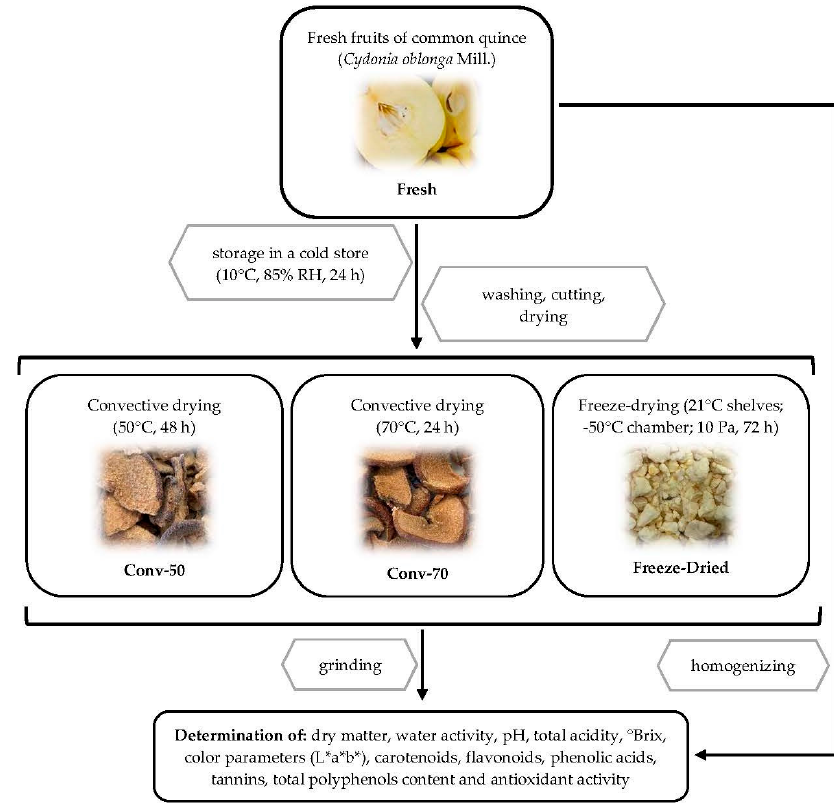
Figure 1. The flowchart of experimental design.